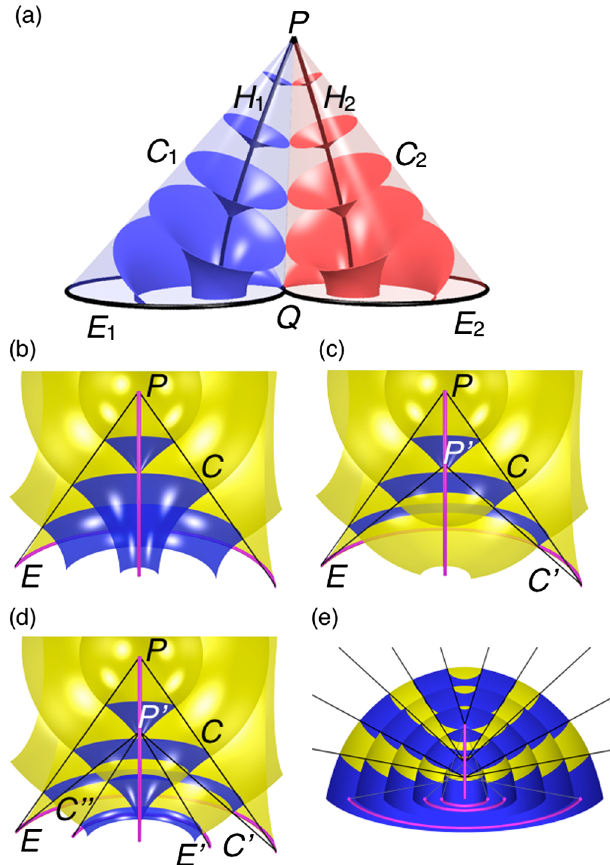
FIG. 3. Geometric construction of a background texture. (a) The LCC in the traditional case of converging hyperbolæ, with focal curves in black. (b-e) Construction of a complex background texture for the flower texture in accordance with the LCC. TFCDs are shown in blue, while concentric spherical regions are shown in yellow. Focal curves are shown in magenta. Black lines outline boundary cones between TFCDs and spheres. (b) One TFCD bounded by a right circular cone C with apex P and base E . (c) The TFCD now occupies the space between two cones C and C 0 , both containing the circular focal curve E but with different apices P , P 0 . Two different families of concentric spherical regions are centered at P , P 0 , respectively. (d) A smaller circle E 0 defines the base of a third cone C 00 as well as the focal curve of a second TFCD bounded by this cone. (e) This construction works also with type-II FCDs. Black lines outlining boundary cones continue past the cone apex to the focal circles as gray